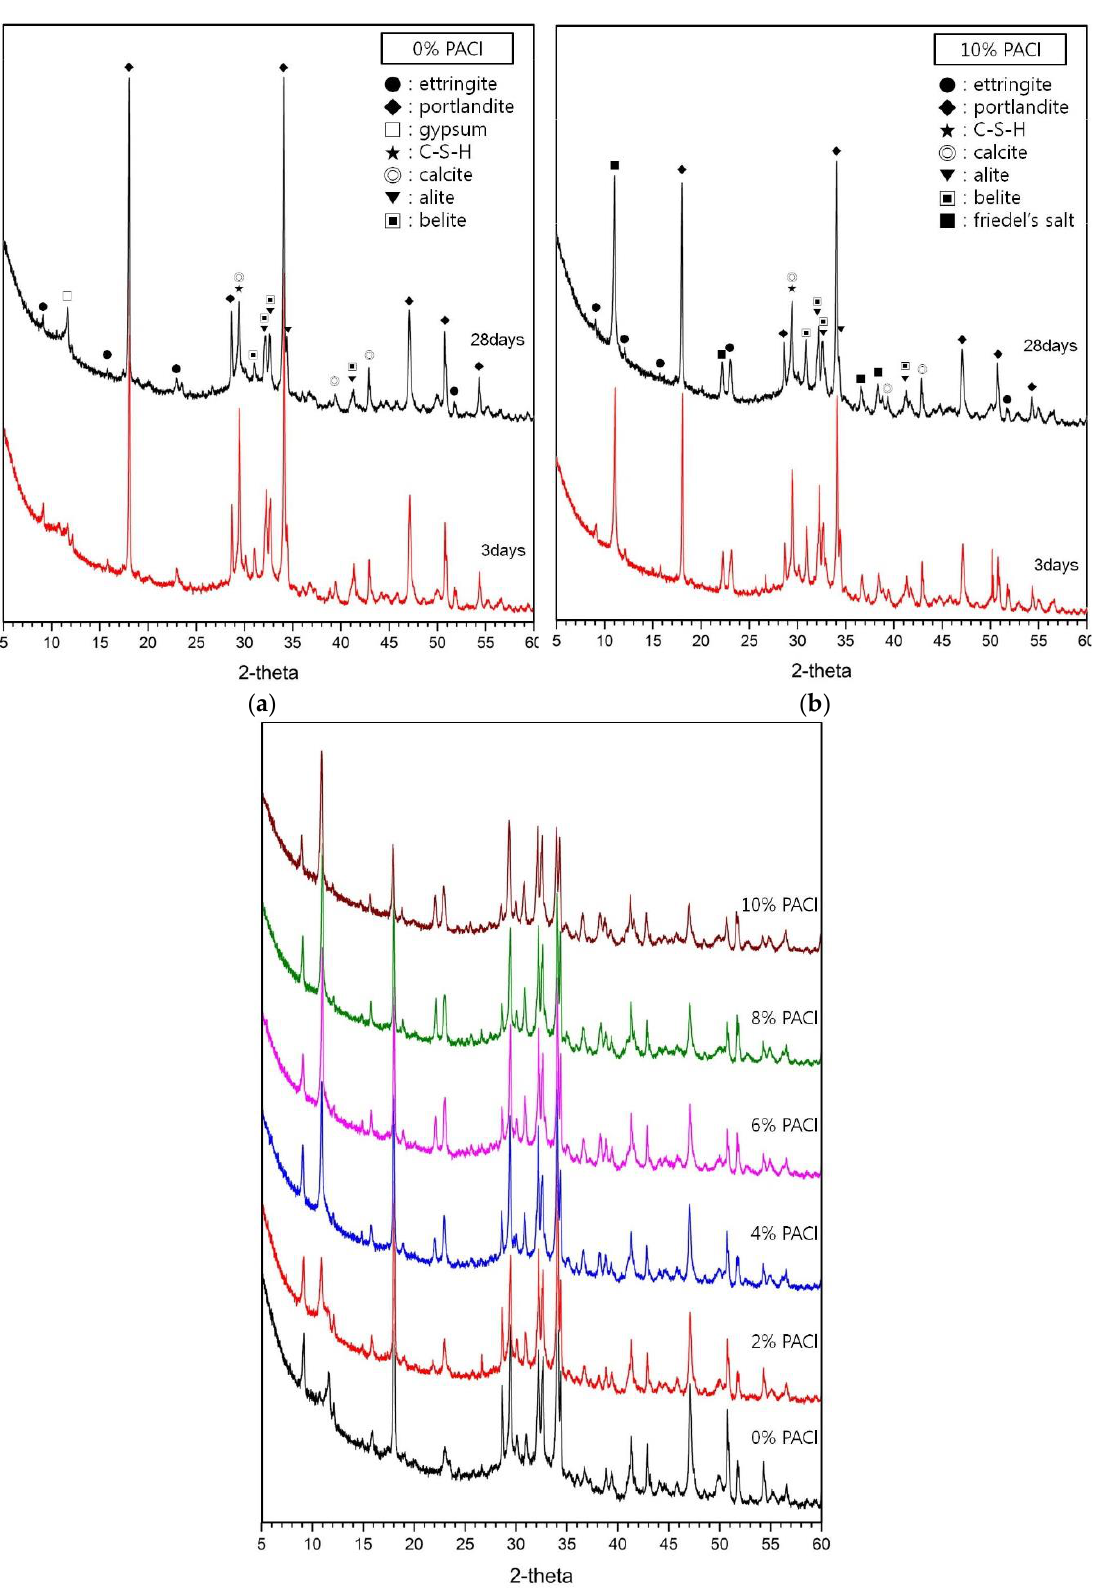
Figure 1. X-ray diffraction (XRD) analysis: ( a ) 0% PACl samples at 3 and 28 days, ( b ) 10% PACl Figure 1. X-ray di ff raction (XRD) analysis: ( a ) 0% PACl samples at 3 and 28 days, ( b ) 10% PACl samples samples at 3 and 28 days, ( c ) comparison of XRD spectra at 28 days. at 3 and 28 days, ( c ) comparison of XRD spectra at 28